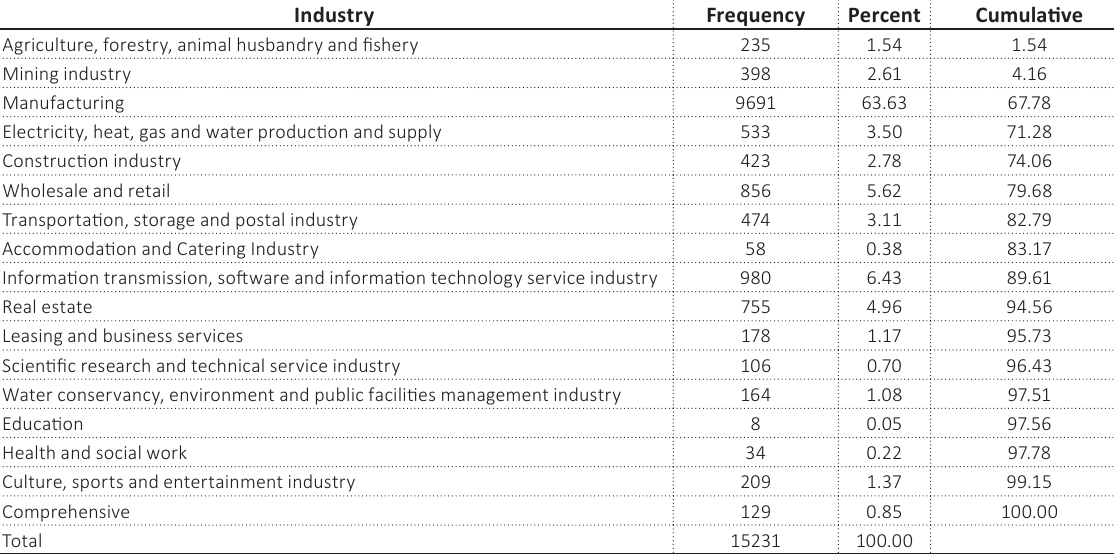
Table 3. Sectoral distribution of the study